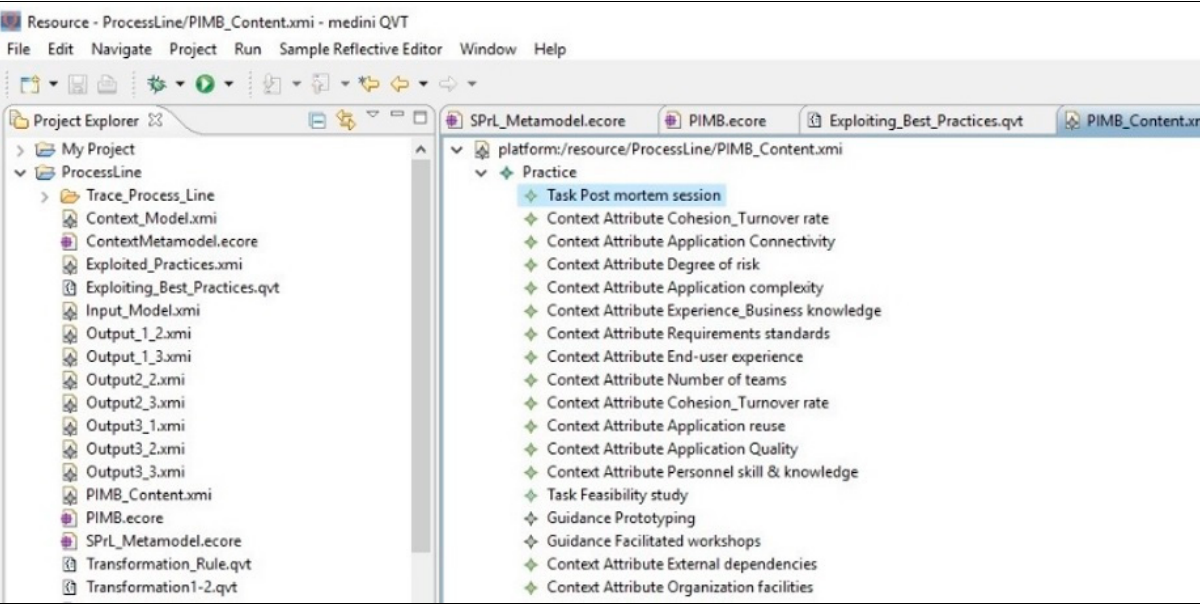
Figure A4. Excerpt of PIMB defined in the tool.